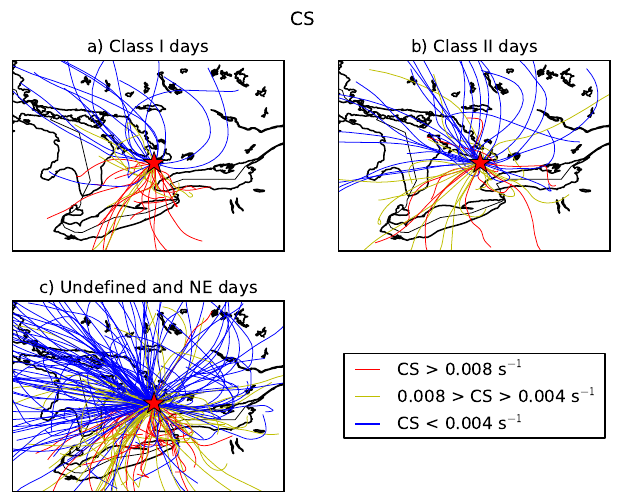
Figure 7. The 24h back trajectories arriving during the new- particle-formation event during each class I, II and undefined + non- event day (one back trajectory per event). Trajectories are color- coded by the condensation sink measured during the event.